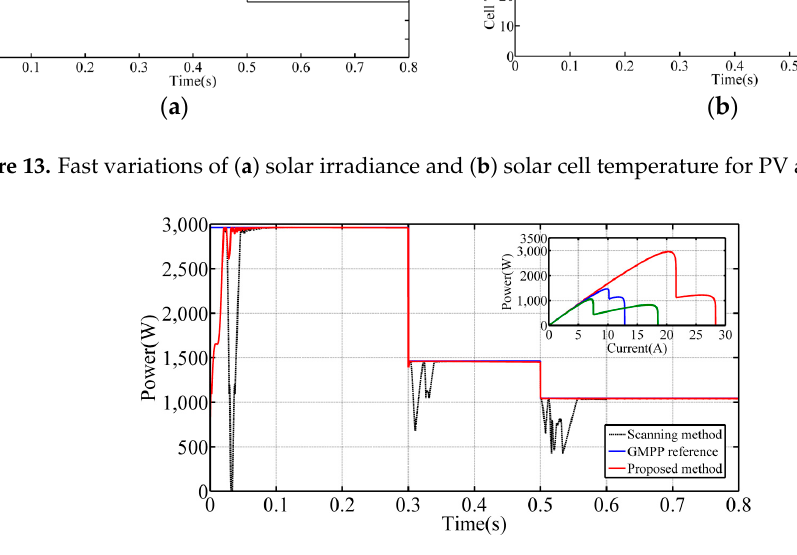
Figure 14. The PV output power for scanning method and OIV-INC algorithm under fast transient variations of shading patterns, with the corresponding P − I characteristic curve.